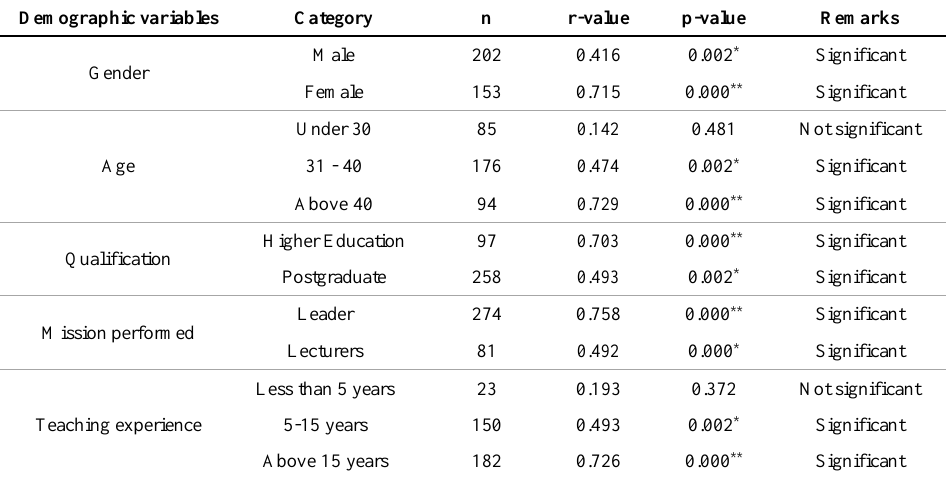
Table 7. Correlation between leadership style and faculty commitment by demographic